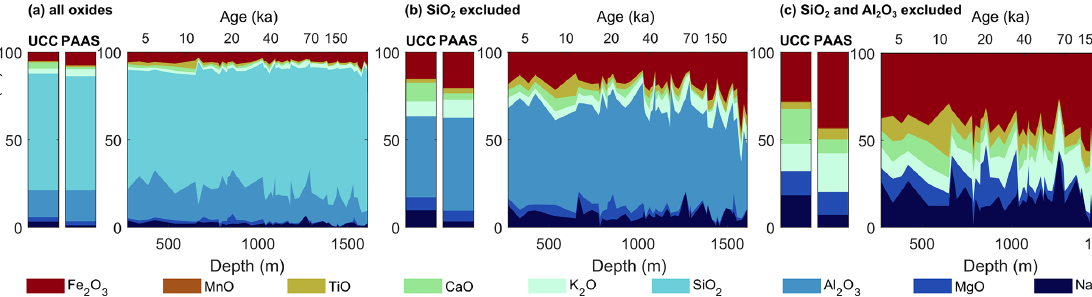
Figure 3. Major element in dust from TALDICE. Data are shown considering all major element oxides (a) , excluding SiO 2 (b) , and excluding SiO 2 and Al 2 O 3 (c) . UCC and PAAS references are shown for comparison (Rudnick and Gao, 2003; Taylor and McLennan, 1985).